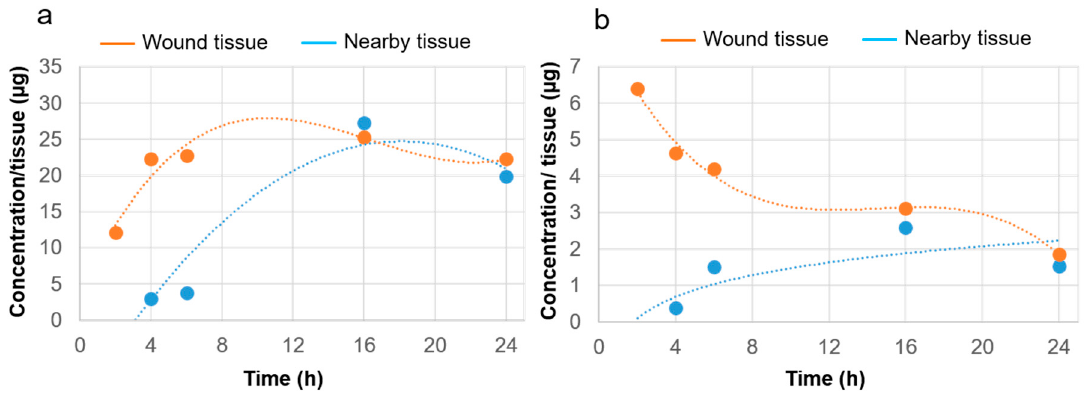
Figure B1. Penetration of ciprofloxacin into the wound and surrounding tissue after the topical application of ( a ) ciprofloxacin-loaded PVP foils (250 µg/wound) and ( b ) a solution of ciprofloxacin base in water (13 µg/wound).